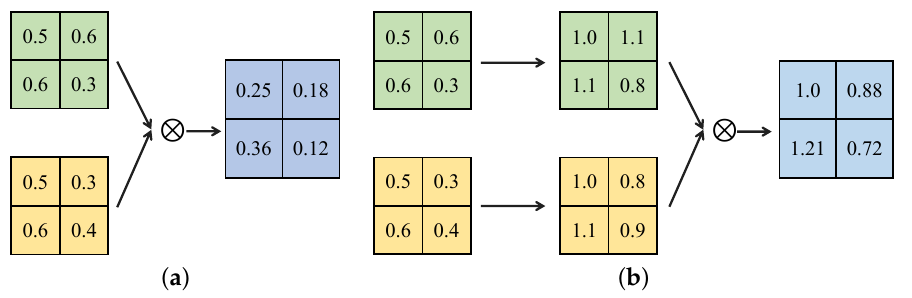
Figure 4. ( a ) Comparison of direct multiplication and ( b ) softplus-post